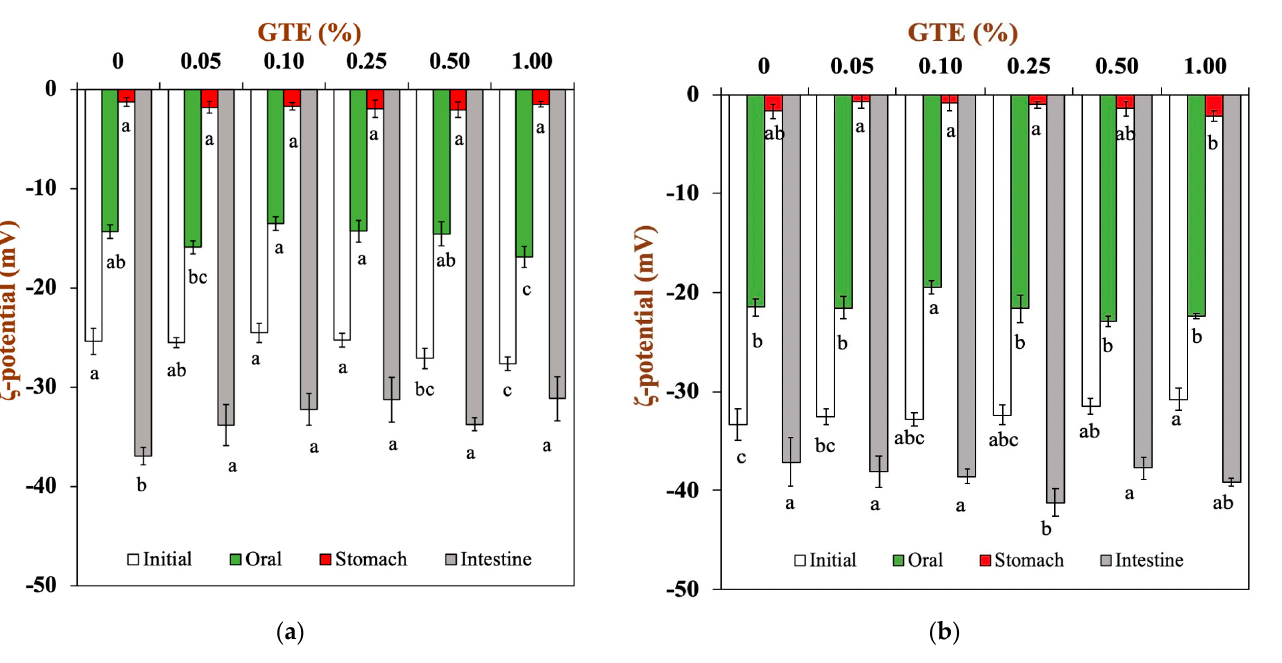
Figure 4. The ζ -potential of oat milk tea model systems after exposure to different in vitro digestive stages: ( a ) 1.5% fat oat milk tea model system and ( b ) 3.0% fat oat milk tea model system. Samples with different lowercase letters indicate significant differences ( p < 0.05) when compared with various concentrations of green tea extract.